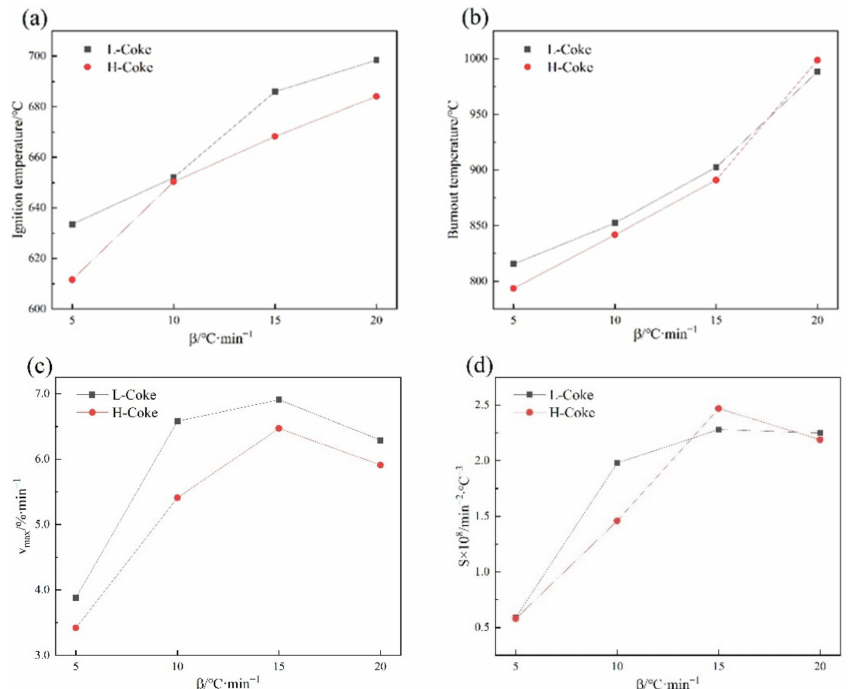
Figure 3. Combustion characteristic parameters of metallurgical coke at different heating rates ( a ) is the relationship between ignition temperature (T i ) and heating rate, ( b ) is the relationship between burnout temperature (T b ) and heating rate, ( c ) is the relationship between maximum weight-loss rate (v max ) and heating rate, ( d ) is the relationship between comprehensive combustion characteristic index (S) and heating